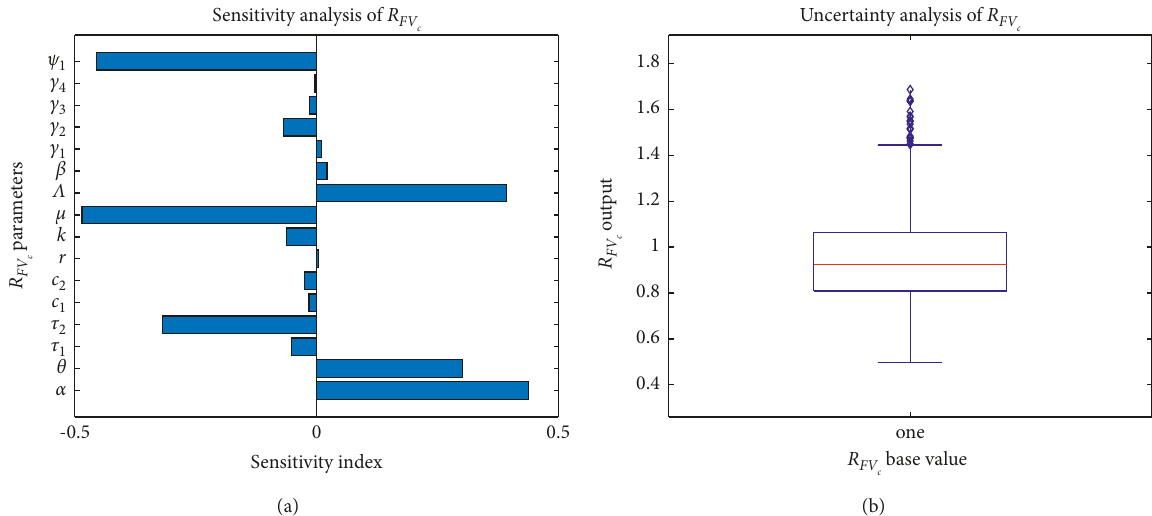
Figure 1: Global sensitivity and uncertainty analysis of variant 1. (a) Partial rank correlation coefficients (PRCC) for variant 1. (b) The box plot of variant